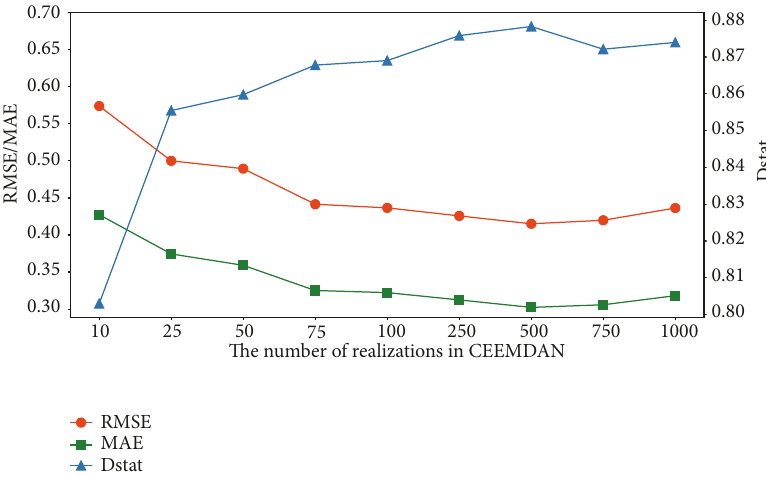
Figure 6: The impact of the number of IMFs with CEEMDAN-XGBOOST.